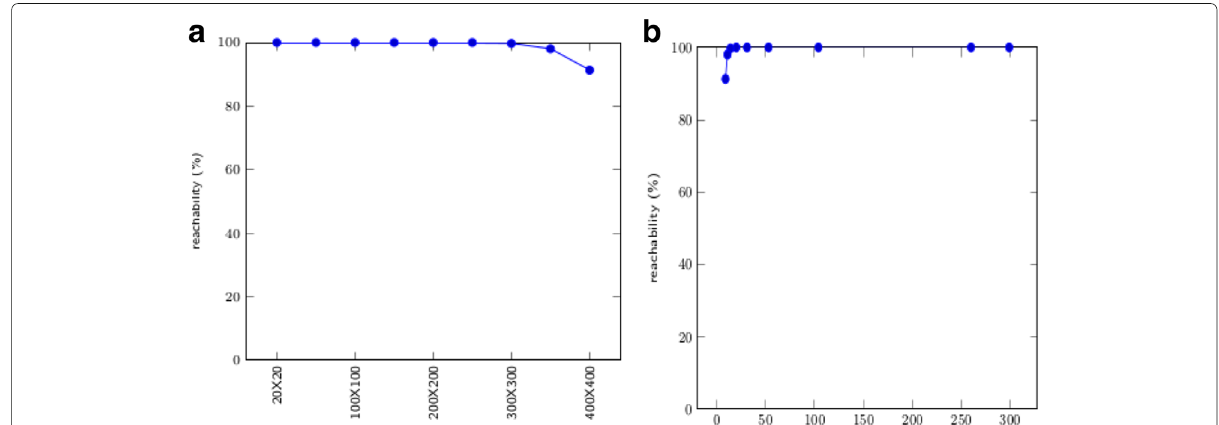
Fig. 23 Reachability of SNCF and CA protocols. Reachability is 100% for SNCF for all the considered network configurations. a Against playground size. b Against node density